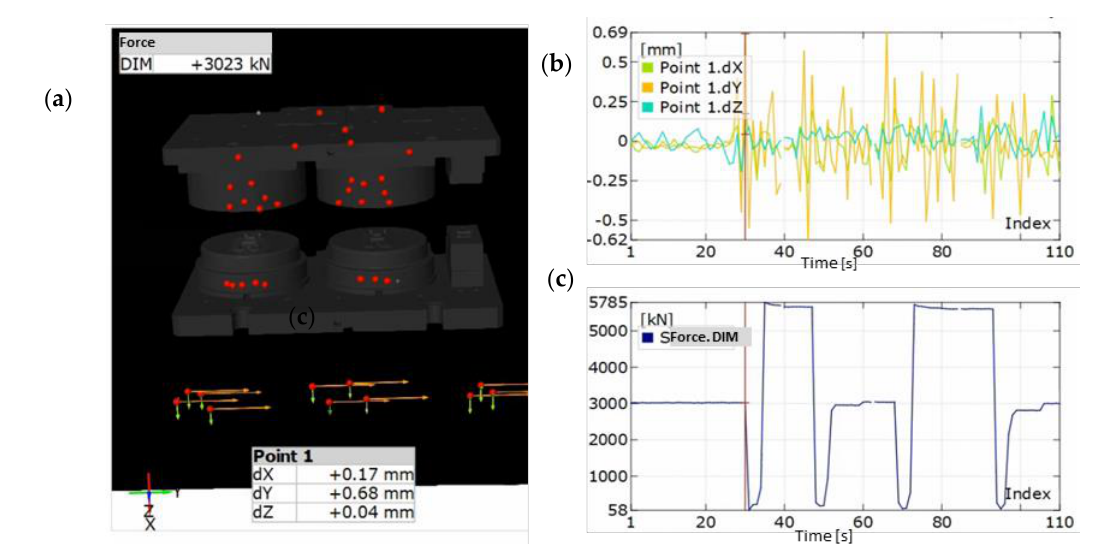
Figure 10. The view of: ( a ) analysis of vibrations of the measuring device without a load, ( b ) change in the position value in axis X, Y and Z, ( c ) change of force value in the process.